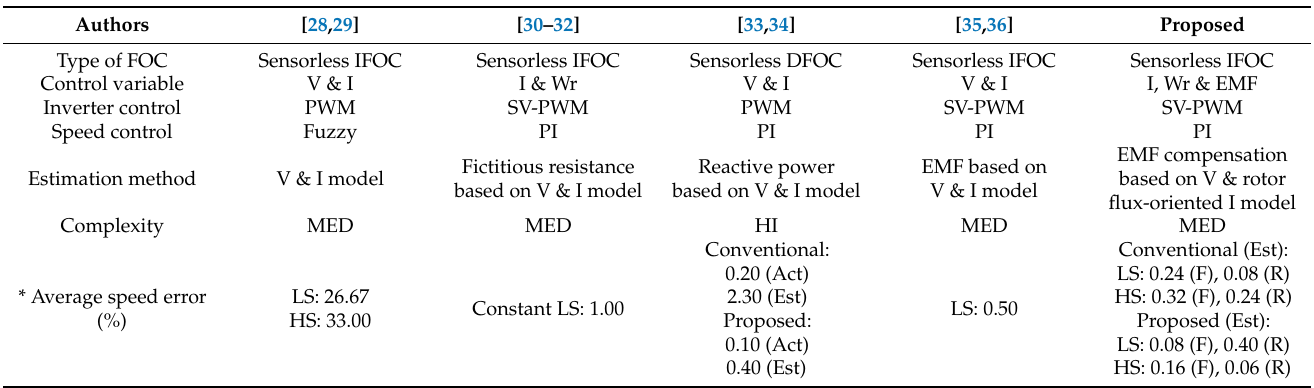
Table 8. Comparison table of FOC scheme with different estimation